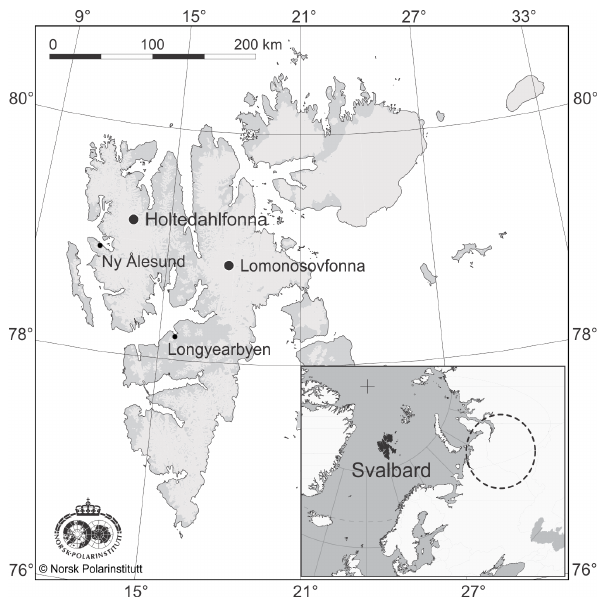
Figure 1. Map indicating the location of the Holtedahlfonna glacier on Svalbard and the geographical location of Svalbard. The circled area in the inset approximately indicates an area with substantial flaring activity in northern